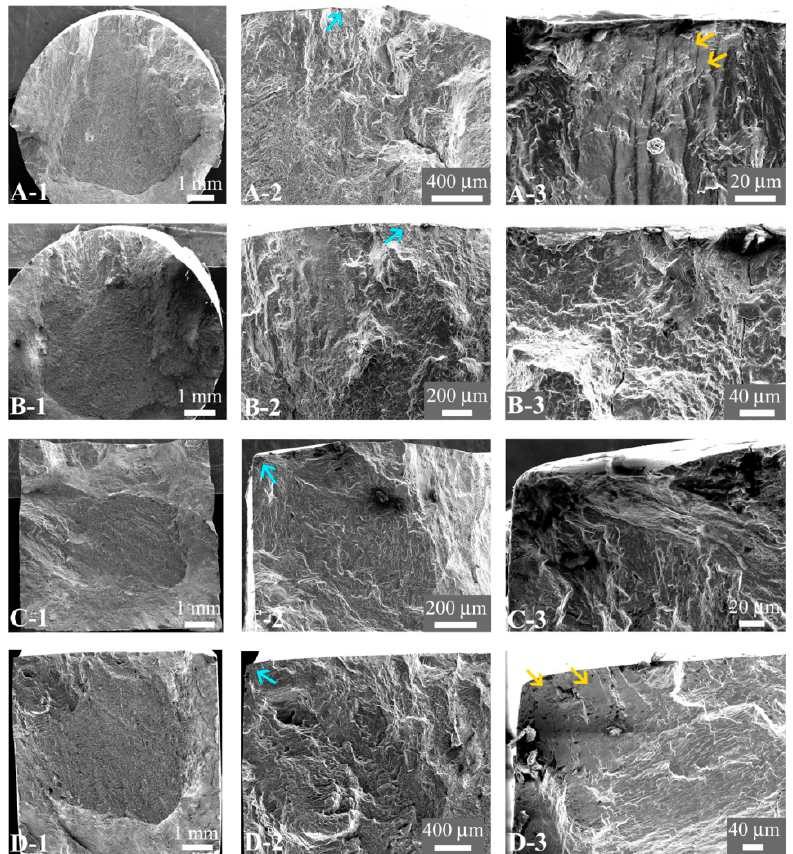
Figure 5. Fracture surface morphology of failed specimens under dwell fatigue test. A-1 ~ A-3: C-specimen with N f = 1016 for rise and fall time 2 s; B-1 ~ B-3: C-specimen with N f = 709 for rise and fall time 2 s; C-1 ~ C-3: S-specimen with N f = 833 for rise and fall time 2 s; D-1 ~ D-3: S-specimen with N f = 665 for rise and fall time 2 s. A-2, B-2, C-2, and D-2 are close-ups of A-1, B-1, C-1, and D-1, respectively; A-3, B-3, C-3, and D-3 are close-ups of the crack initiation regions where the arrows point to in A-2, B-2, C-2, and D-2, respectively; the arrows pointing to in A-3 and D-3 denote the